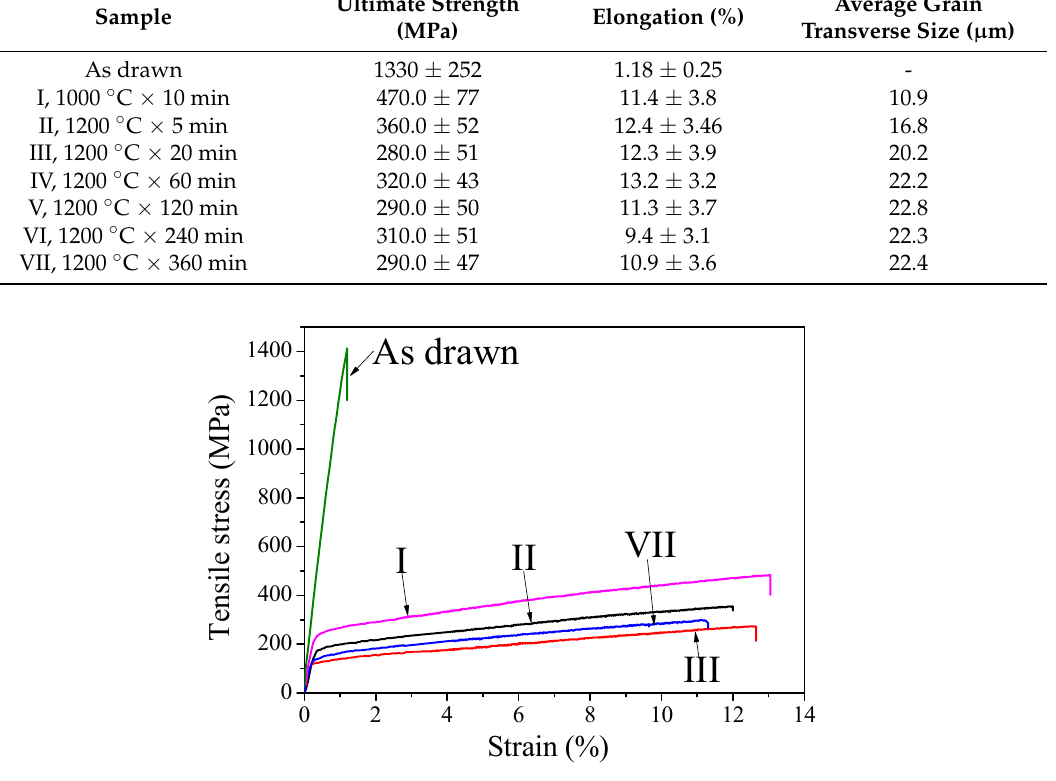
Figure 5. Tensile stress-strain curves of single fibers.